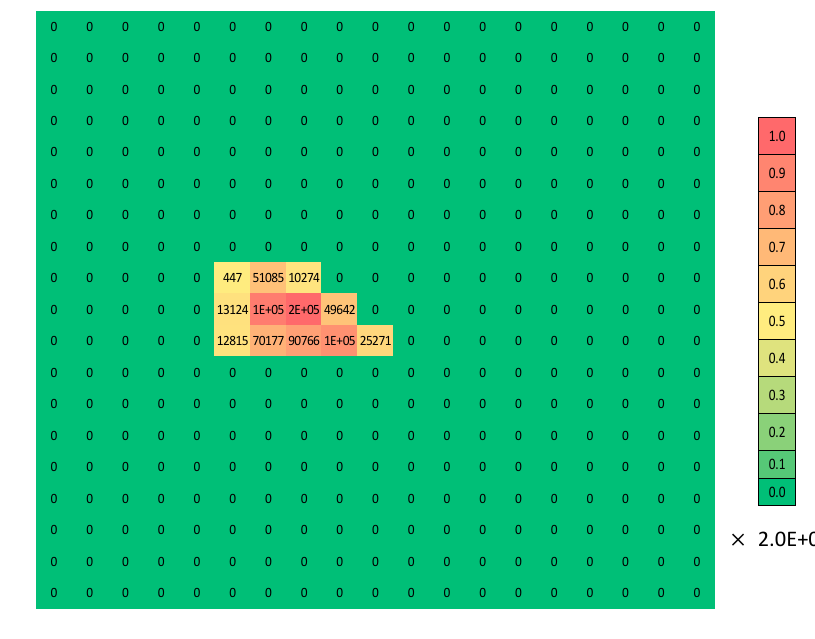
Figure 6. Distribution on the 19-by-19 microbolometer array of collimated rays forming Beam 1 in Figure 7.